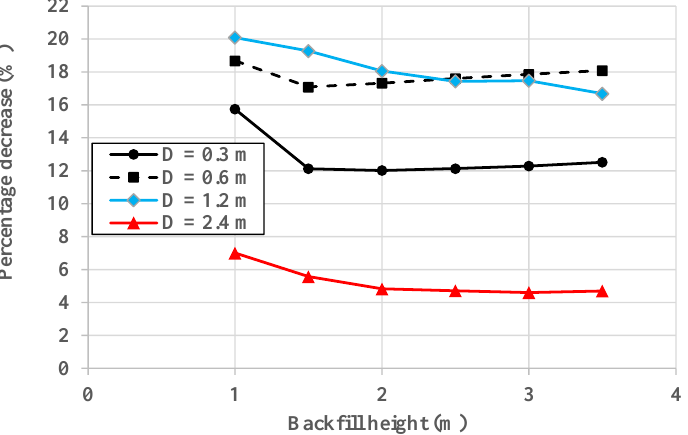
Figure 14. Effect of the pipe diameter and backfill height on the percentage decrease of the maximum bending moment for the TDA 1.